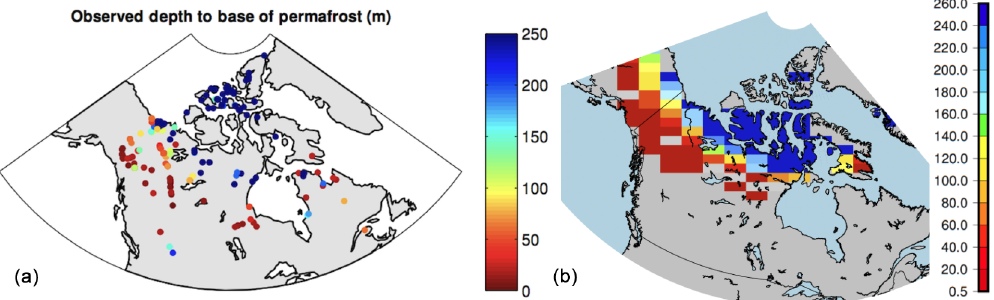
Figure 9. Observed depth of permafrost for the region of northern Canada (a) (data source: Smith and Burgess, 2002; figure source: Avis, 2012). The colour bar has been restricted to 250m depth to aid in comparison despite the fact that many locations are deeper (Avis, 2012). Simulated mean permafrost depth for 1966–1990 of the UVic ESCM 2.10 (b) .